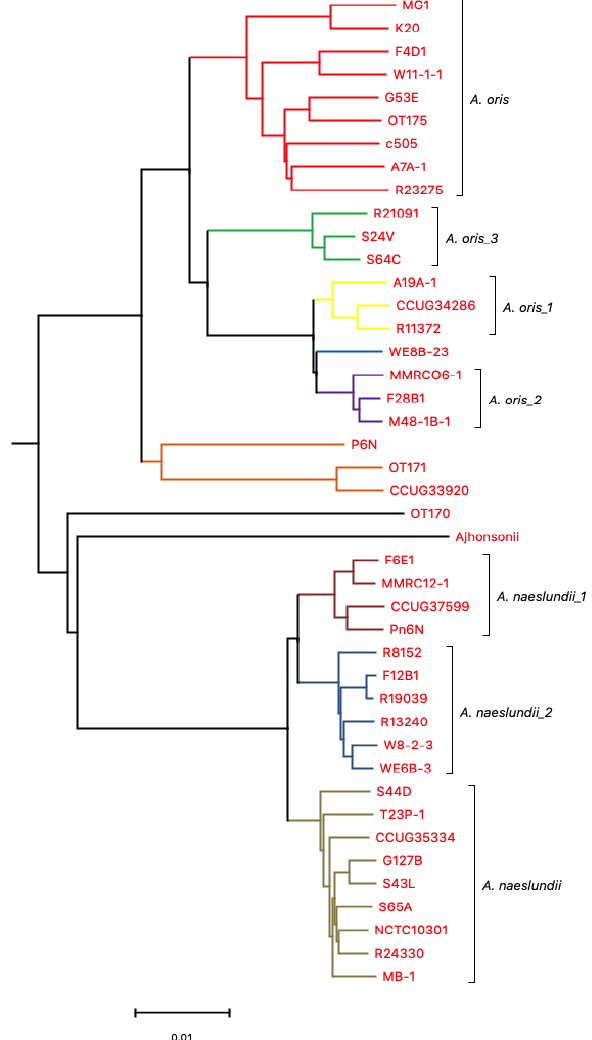
Figure 1. A phylogenetic tree showing relationship after Mauve run of 43 Actinomyces genomes.